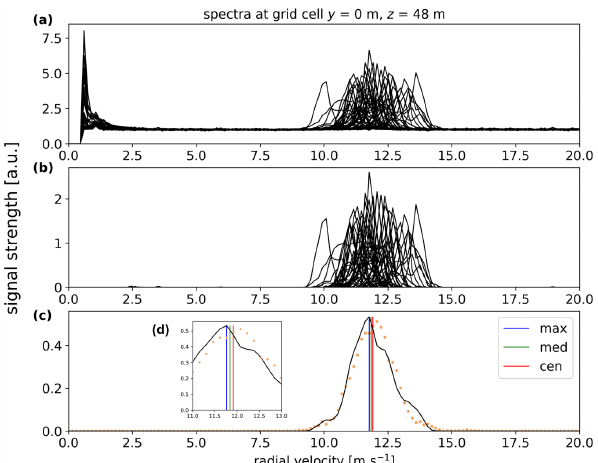
Figure 7. An example of Doppler radial velocity spectra analysis within a 10min period (26 February 2021 at 14:10:00). The location of the grid cell y = 0m, z = 48m is shown in the scanning pattern in Fig. 6b. (a) Raw and scaled Doppler radial velocity spectra. (b) Cleaned and normalized Doppler spectra. (c) The average Doppler spectrum (black), the distribution of the sonic measurements at hub height (orange) and the three radial velocity estimates, which can be clearly seen in the inset (d)